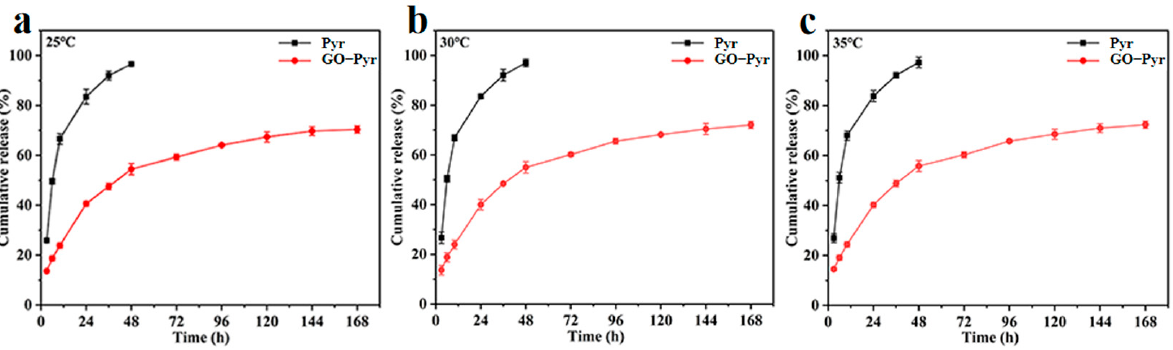
Figure 4. Release kinetics of Pyr and GO–Pyr nanocomposite at 25 °C ( a ), 30 °C ( b ) and 35 °C ( c ). Data are mean of cumulative release rate ± SE ( N = 3).